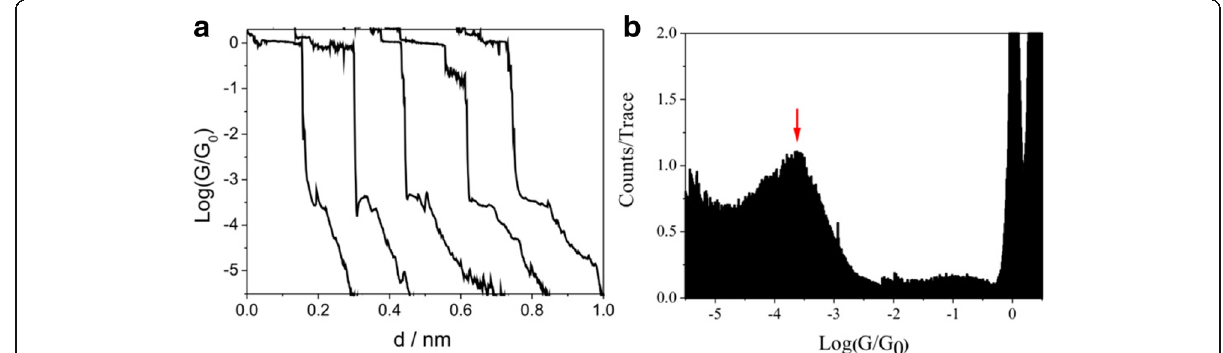
Fig. 2 Single molecular conductance of Au – 1,4-butanediiodo – Au junctions. a Typical conductance curves of Au – 1,4-butanediiodo – Au junctions measured at a bias of 100 mV. b Log-scale conductance histogram of 1,4-butanediiodo junctions with Au